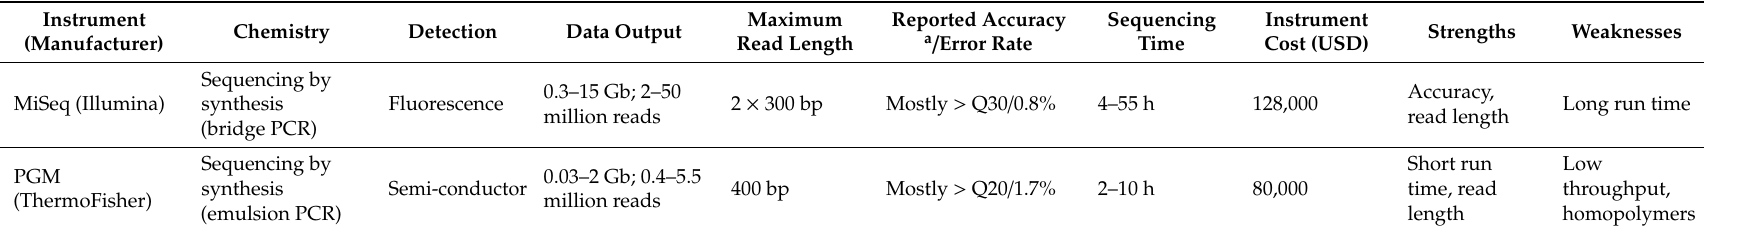
Table 3. General features of the two currently most commonly used NGS platforms in HIVDR